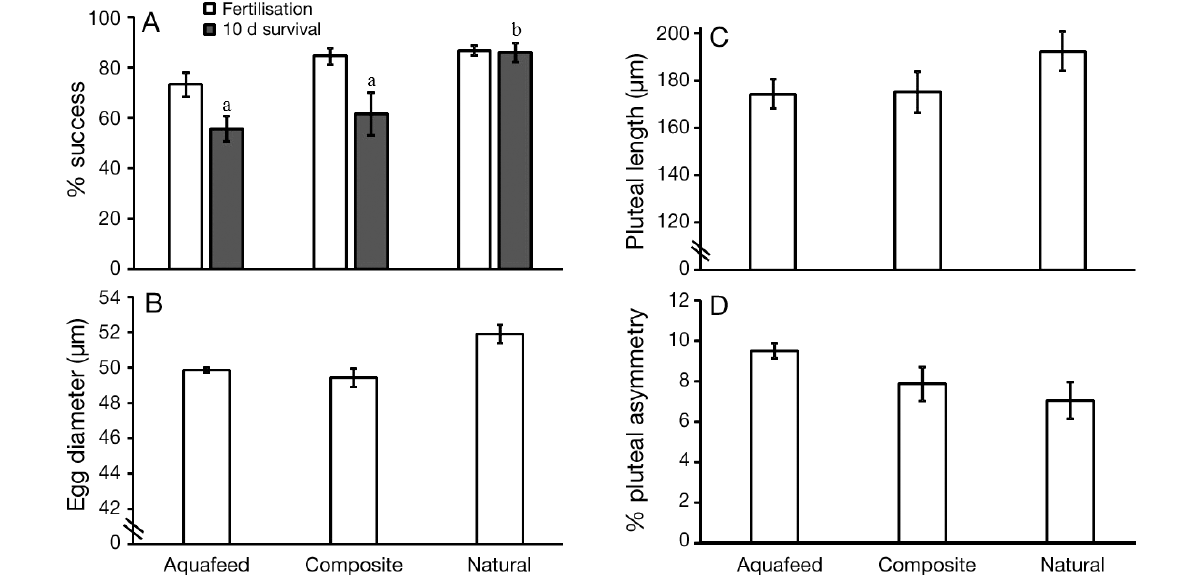
Fig. 2. Mean (±SE) effects of dietary treatment on larval success and development of Gracilechinus acutus measured as (A) % fertilisation success and % survival 10 d post fertilisation, (B) egg diameter (µm), (C) pluteal length, being the average length of the pluteal arms (µm) and (D) % asymmetry obtained by the difference in length of pluteal arms. Superscript letters in (A) denote significant treatment